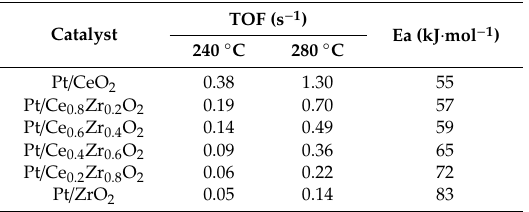
Table 5. Turnover frequency (TOF) and activation energy (Ea) for WGS reaction over Pt / CeO 2 , PtZrO 2 and Pt / Ce (1 − x) Zr x O 2 catalysts, date from [82]; at P = 1 atm, 6.5% CO, 7.1% CO 2 , 0.7% CH 4 , 42.4% H 2 ,